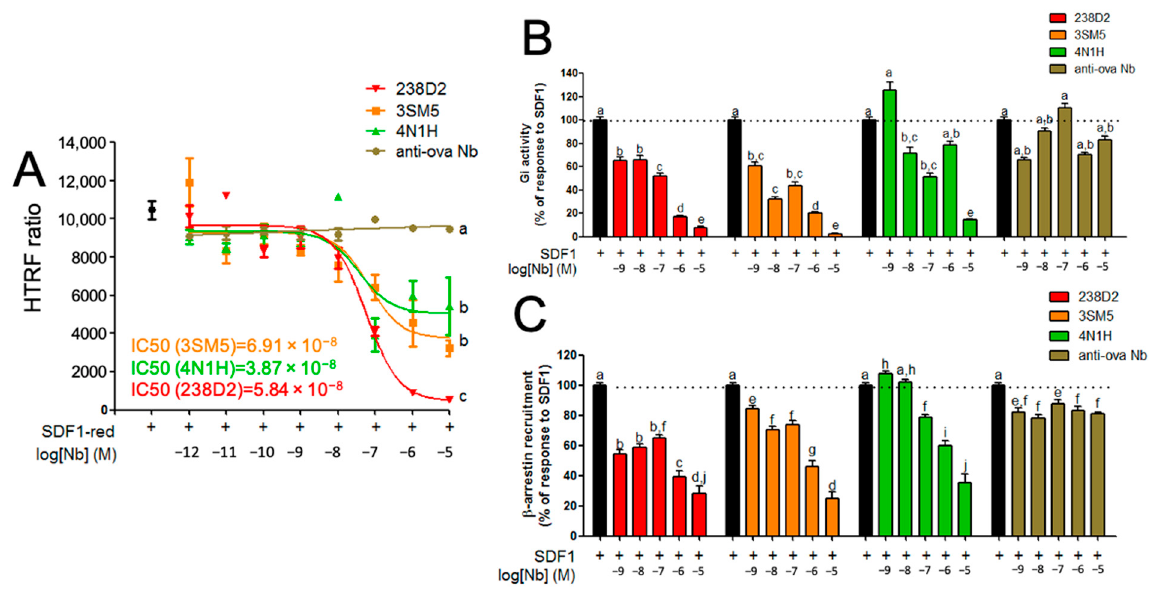
Figure 3. 3SM5 and 4N1H bind CXCR4 and trigger the same intracellular signaling as 238D2. ( A ) SDF1 displacement. HEK293FT cells expressing the Terbium-linked SNAP-tagged CXCR4 were incubated with d2-coupled SDF1 to measure the ligand binding as an initial FRET signal (black dot). Increasing doses of the Nbs (238D2 in red, 3SM5 in orange, 4N1H in green, and the anti-ovalbumin Nb in brown) from 1 pM to 10 µM were added. Results are shown as the FRET ratio of emission light of the acceptor (d2) divided by the emission of the donor (Tb). ( B ) Gi protein activity. HEK 293FT cells transiently expressing the hCXCR4 and the CAMYEL cAMP sensor were incubated with forskolin (100 µM) to induce basal cAMP production and SDF1 (50 nM) to induce Gi activation (black bars). The BRET ratio (emission of acceptor/emission of donor) was calculated while increasing Nb concentration from 1 nM to 10 µM. ( C ) β -arrestin recruitment to CXCR4. In HEK293FT cells transiently expressing Rluc8-fused CXCR4 and YPET- β -arr2, β -arrestin 2 recruitment to the CXCR4 was induced with 50 nM SDF1 (black bars). BRET ratio was measured at indicated concentrations of Nb (from 1 nM to 10 µM). Identical letters show no statistical difference, and different letters show statistical differences at p <